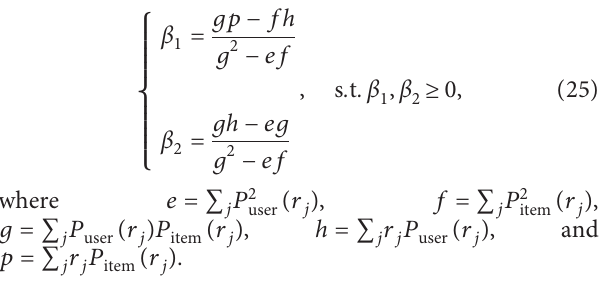
algorithm and propose a hybrid recommendation